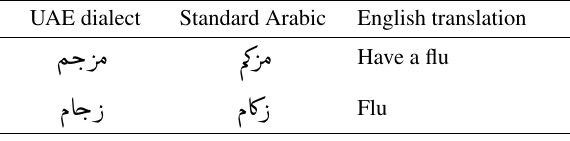
Algorithm 1 repTweet